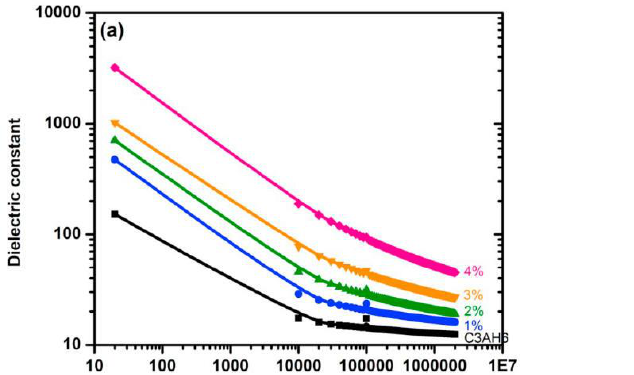
Figure 31. Relative permittivity of cement composites with different GO concentrations within different frequency ranges ( a ) 1 – 10 2 Hz; ( b ) 10 2 – 10 4 Hz; ( c ) 10 4 – 5×10 6 Hz. Reprinted with permission from Ref. [127]. Copyright 2019 Elsevier.